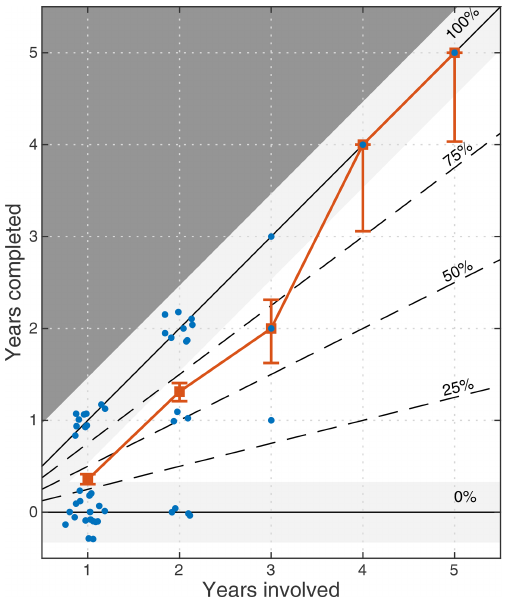
Figure 6. The number of years each school completed a PRiSE project against the number of years they were involved. Data points (blue) have been jittered for visibility. The average number of years completed and standard Clopper and Pearson (1934) interval for this rate are also shown